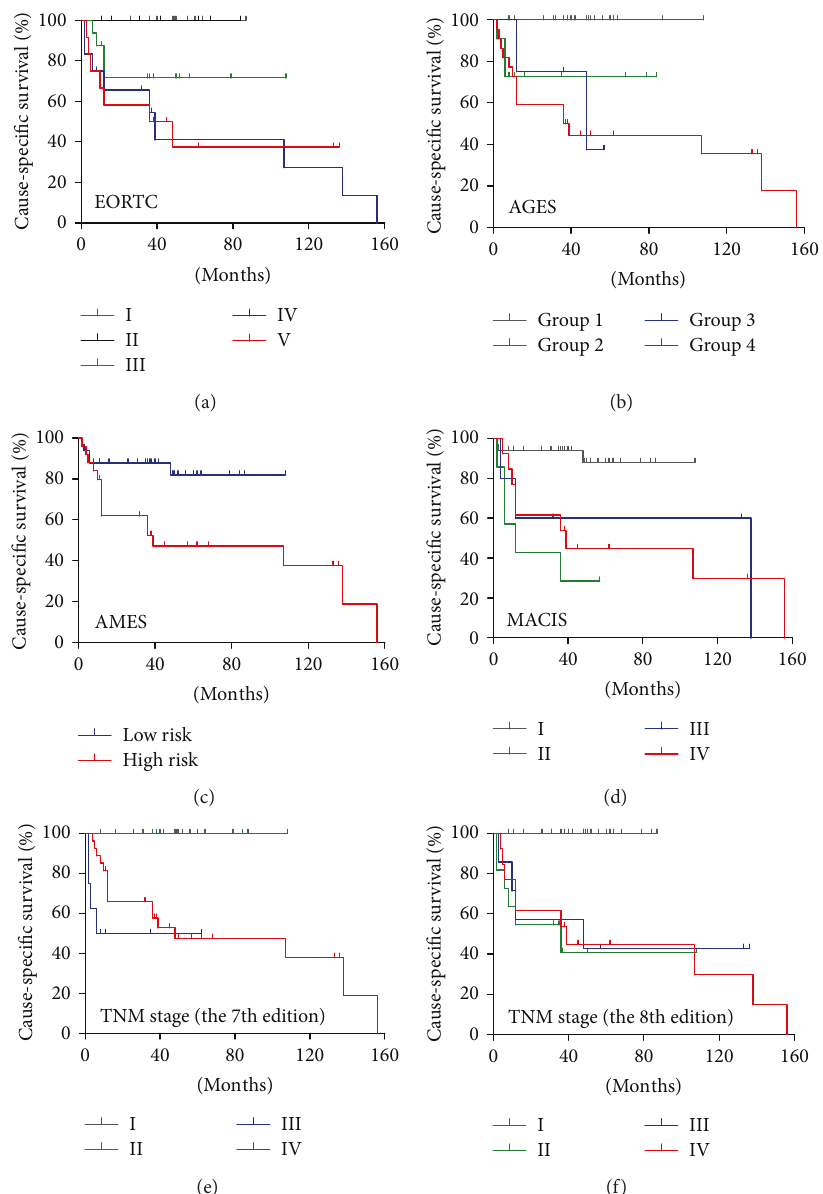
Figure 4: Kaplan-Meier curves of CSS for the prognostic classi fi cation systems. (a – f) The Kaplan-Meier curves of CSS according to the prognostic classi fi cation systems including EORTC, AGES, AMES, MACIS, the 7th edition TNM, and the 8th edition